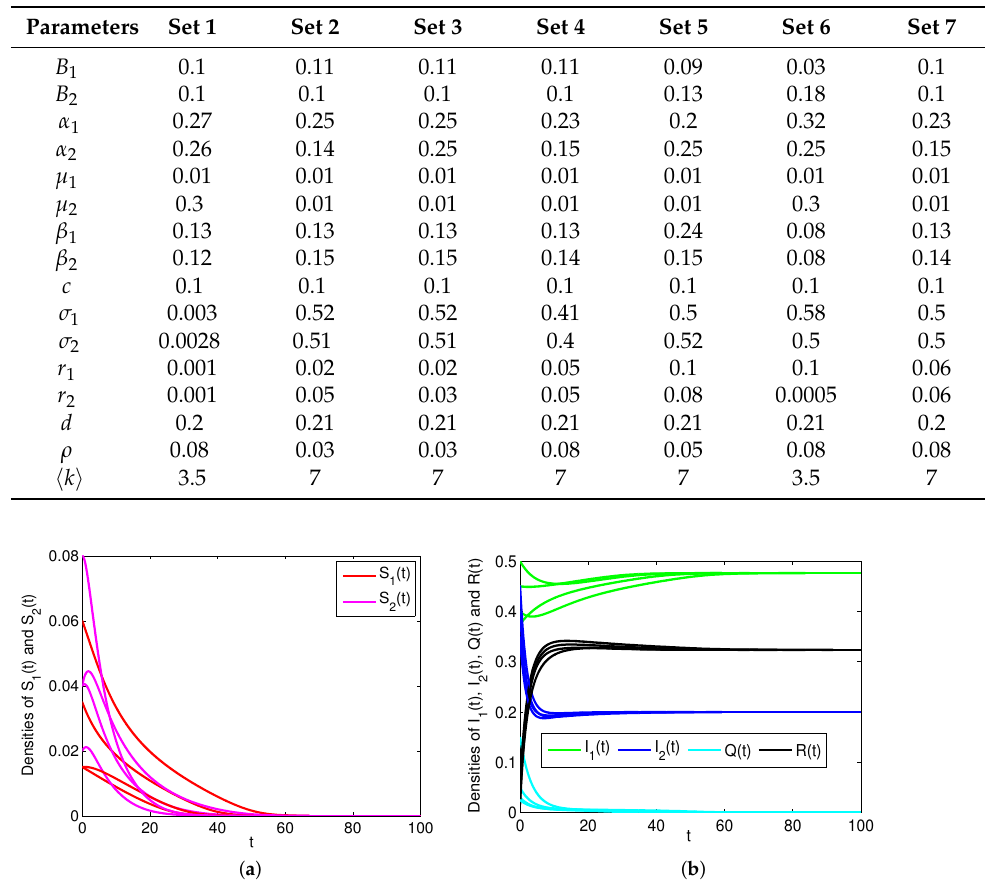
Table 1. The set of parametric values for simulation.